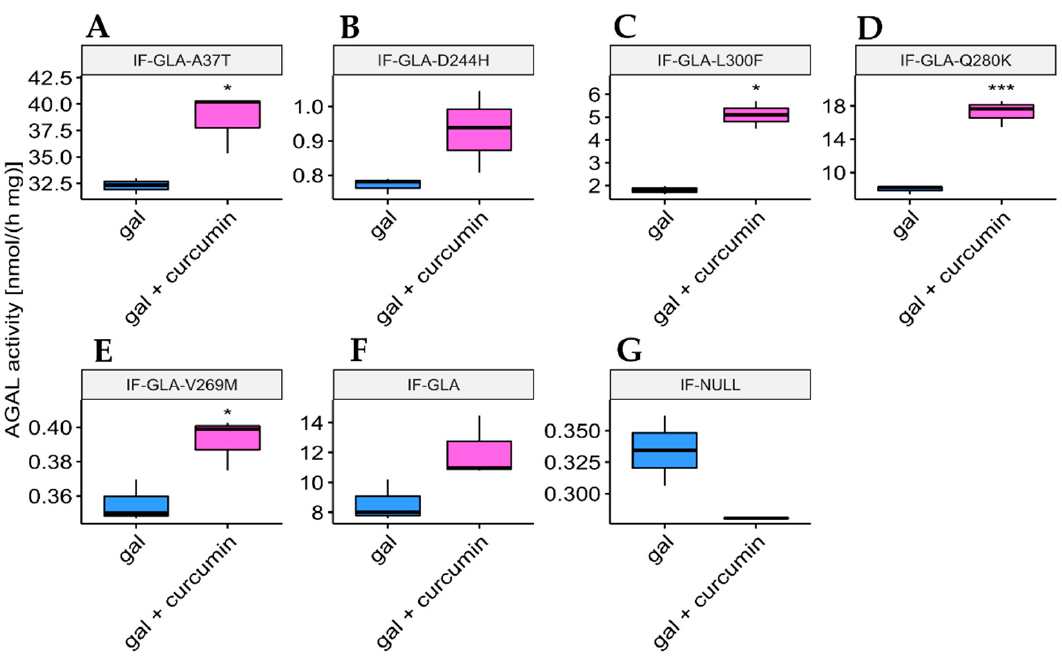
Figure 5. AGAL activity increased upon combined treatment with galactose and curcumin. IF-GLA and IF-GLA-MUTs were treated for 48 h with 100 mM galactose in the presence or the absence of 20 µ M curcumin. The AGAL-specific activity was then tested on cell protein extracts. The effect of galactose potentiation was appreciated in four out of the five tested mutants (two-tailed unpaired